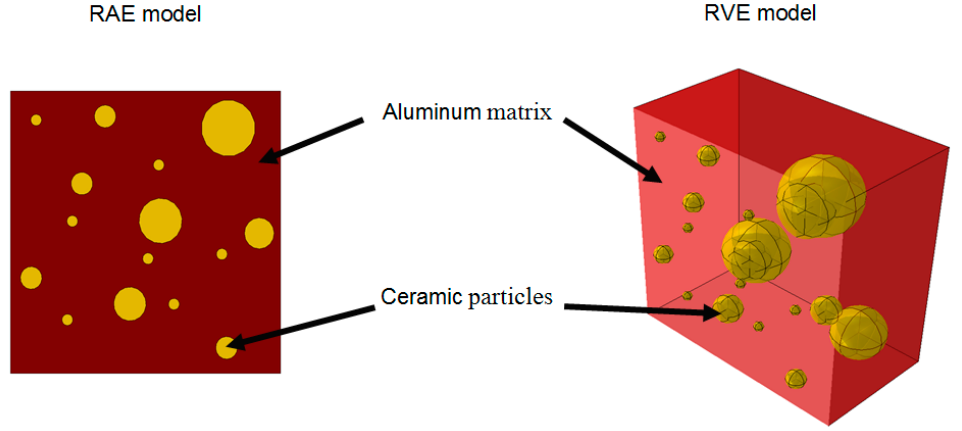
Figure 2. Microstructural model of RVE and RAE unit cells in which each RAE is a slice of a respec- tive RVE.